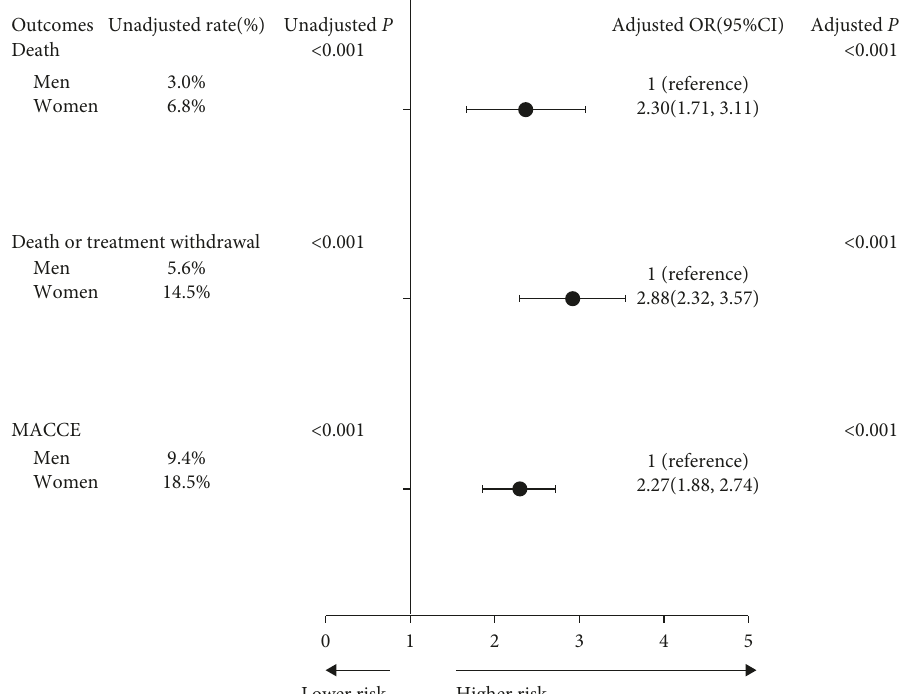
Figure 2: In-hospital outcomes based on sex in STEMI patients. The worse in-hospital outcomes were performed in female STEMI patients, and the differences between sexes were statistical significance in in-hospital death (6.8% in females vs. 3.0% in males, P < 0 . 001), death or treatment withdrawal (14.5% in females vs. 5.6% in males, P < 0 . 001), and MACCE (18.5% in females vs. 9.4% in males, P < 0 . 001). Adjustment for clustering of patients within hospitals in the generalized linear mixed model, and the sex differences were significant between men and women with respect to death, treatment withdrawal, or complications during hospitalization. Adjusted OR of 1 shows no difference from male patients. STEMI, ST-elevation myocardial infarction. MACCE, main adverse cardiovascular and cerebrovascular